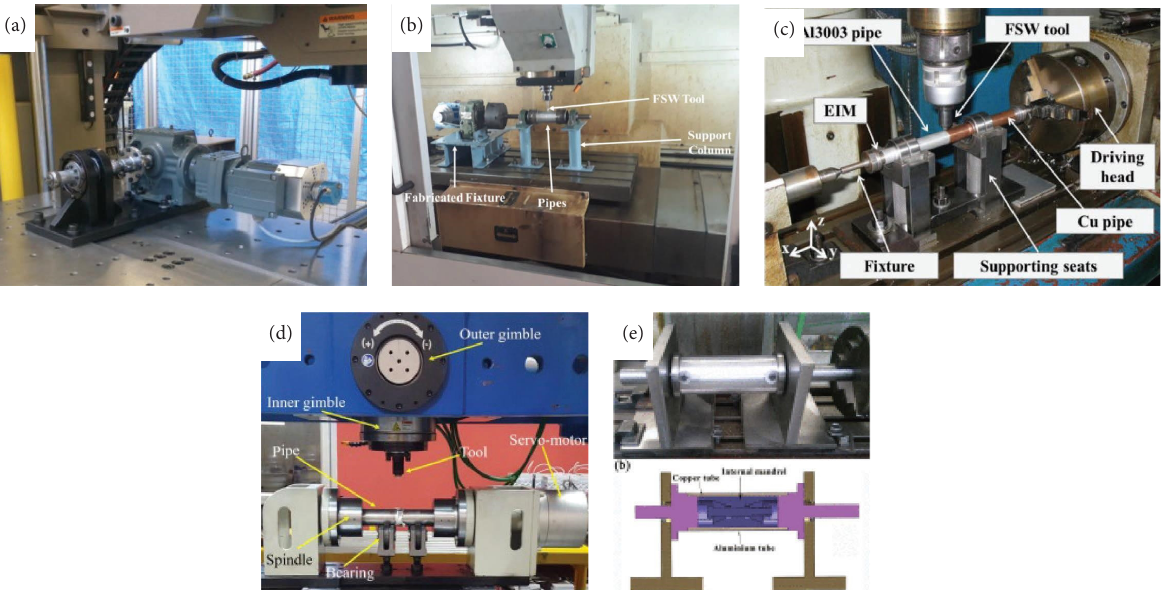
Figure 12: Various fxtures employed for friction stir welding of pipes (a) fully automated fxture for similar welding [100], (b) semi- automated fxture for similar welding [46], (c) fully automated fxture for dissimilar welding [114], (d) fxture with bottom roller supports [138], and (e) fxture for lap joint of pipes [111].